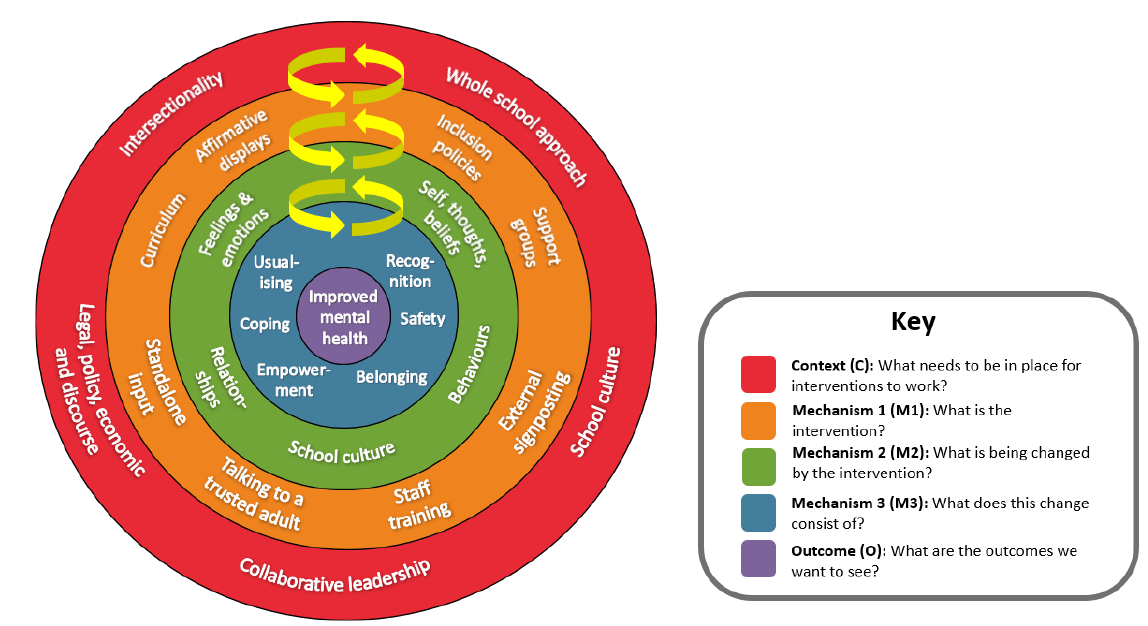
Figure 1. Programme theory.